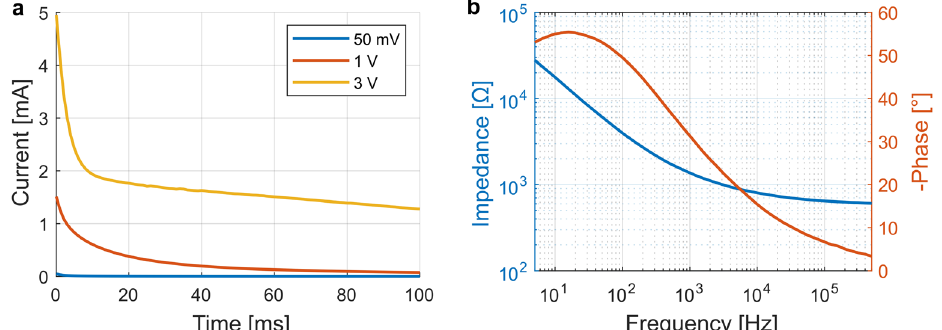
Figure 4. Electrochemical characterization of the custom-made cuff electrodes in saline solution. The characterization was performed in a bipolar configuration between the two stimulation electrodes in the cuff. ( a ) Chronoamperogram for three different voltage step amplitudes. ( b ) Impedance spectroscopy analysis exhibiting a combined impedance of ~ 1.4 kΩ @ 1